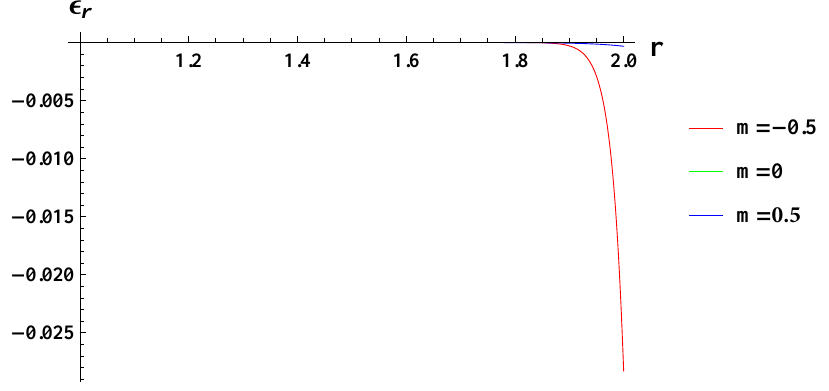
Figure 22. Tangential stress (in MPa) along the radius r (in cm) of the cylinder, under the effect of rotation ( ω 2 = 50 rad/s), internal pressure p i = 50 MPa and quadratic volume reinforcement.